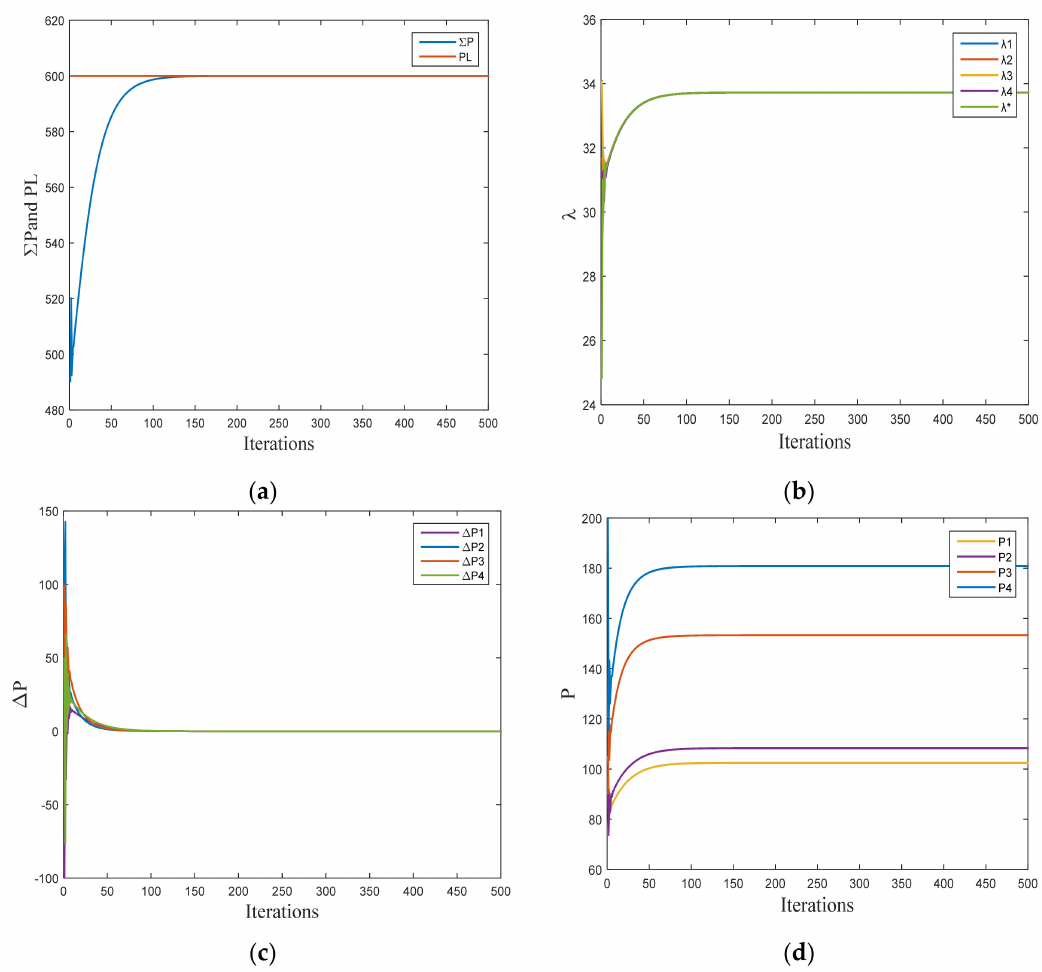
Figure 10. Process of economic dispatch under the ideal communication environment; they should be listed as: ( a ) Total system power output; ( b ) Incremental cost; ( c ) Estimated local power mismatch; ( d ) Output